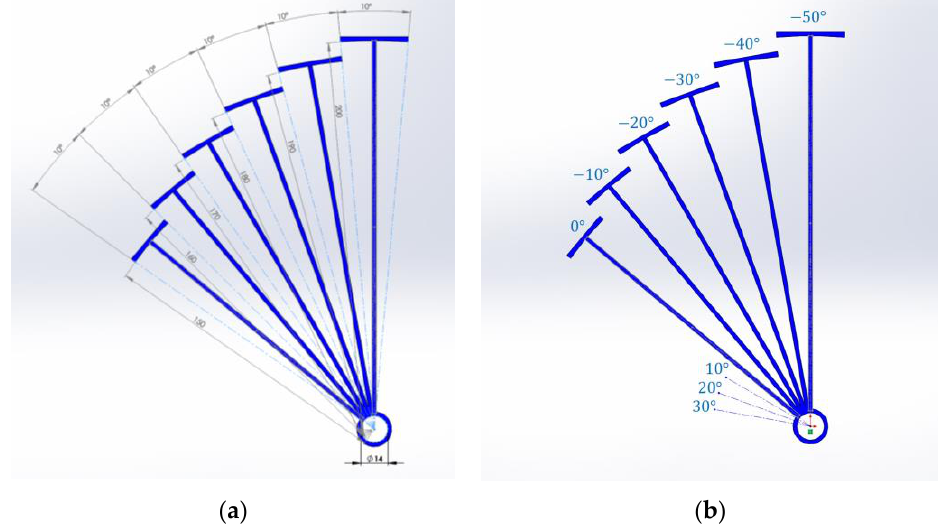
Figure 5. The designed RML structure for ( a ) dimensions in millimeters and ( b ) angles in degrees.